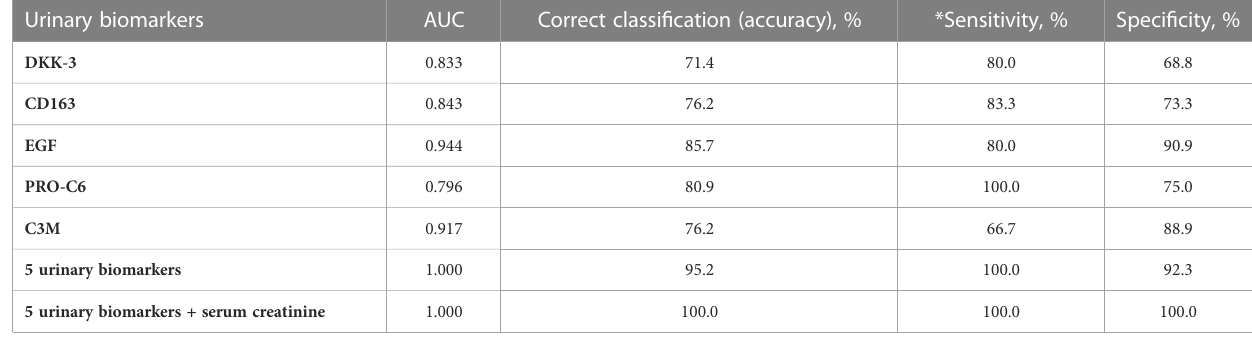
TABLE 3 AUC (from ROC), accuracy, sensitivity and speci fi city of the discrimination of Focal class from Crescentic class with selected urinary biomarkers. Urinary biomarkers